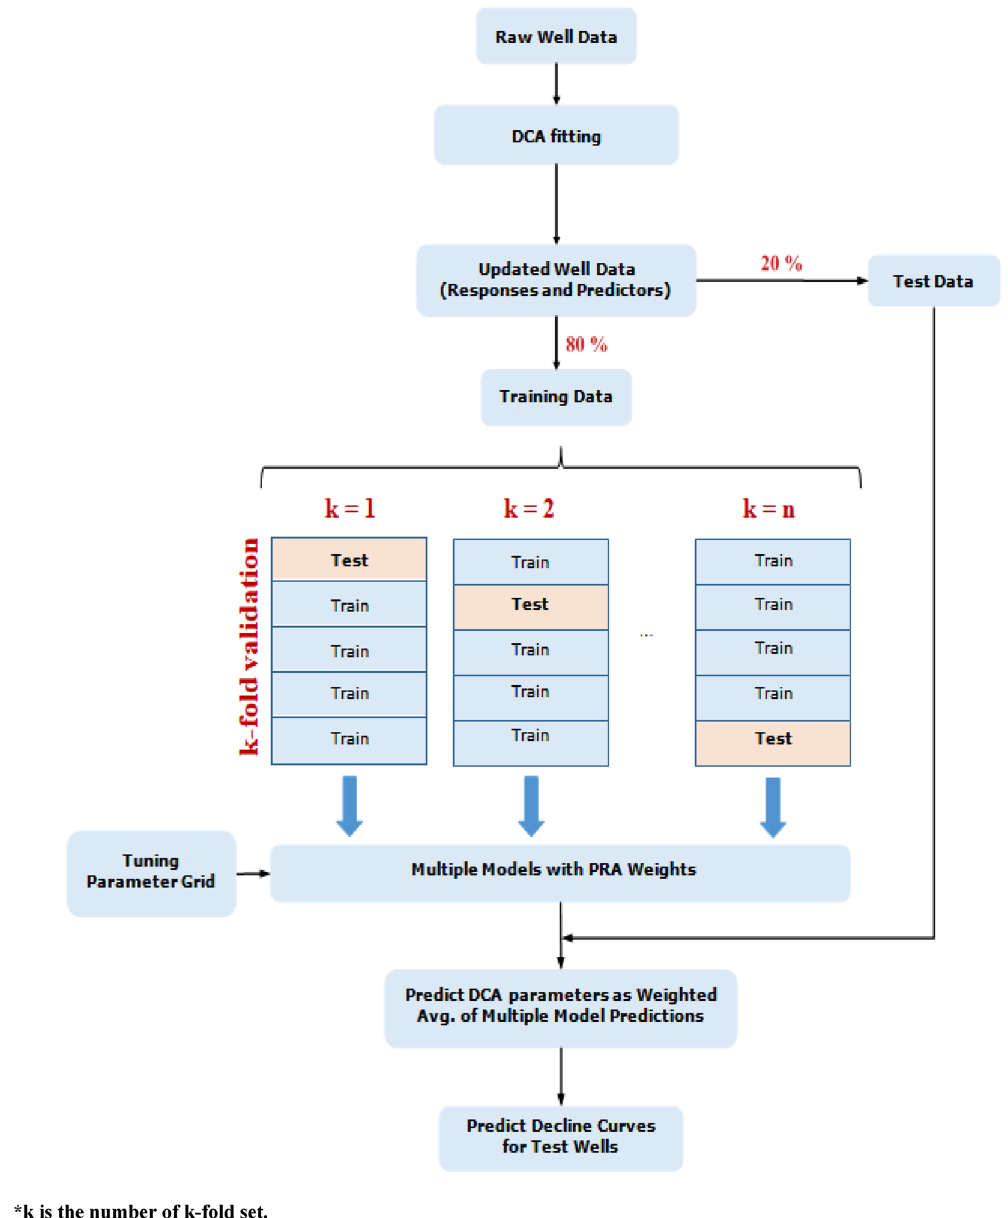
Figure 22. Workflow to build multiple models and average them (modified from Vyas et al. 1